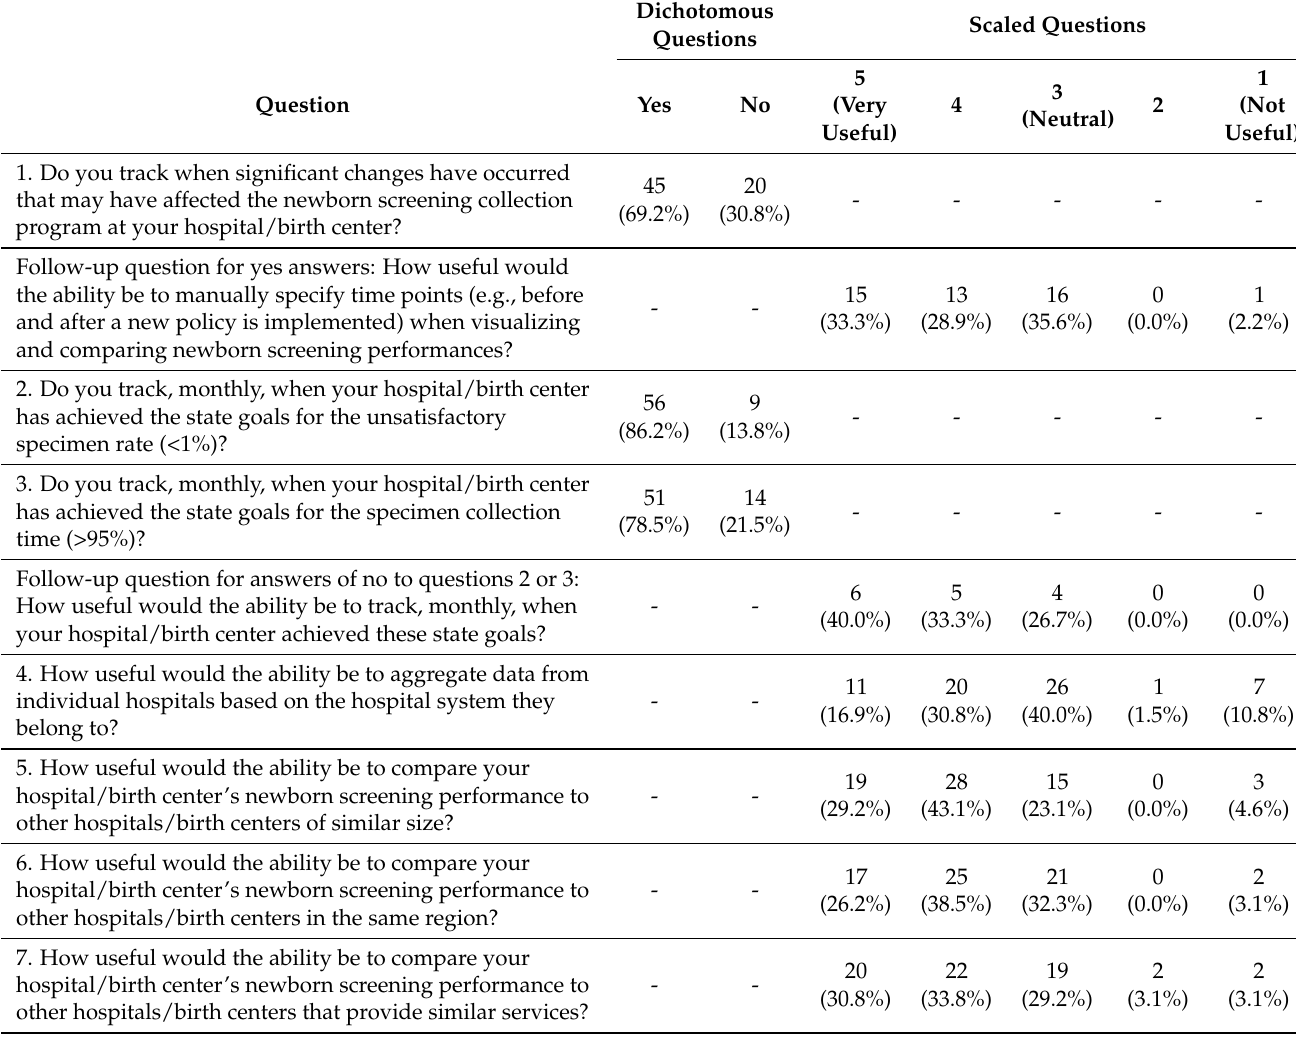
Table A1. The questions and responses to the dashboard development survey given to 68 Tennessee facility NBS staff. Three participants did not respond. Most features surveyed for were regarded as useful. Survey respondents’ information and interest in participating in a focus group to provide further dashboard feedback were also